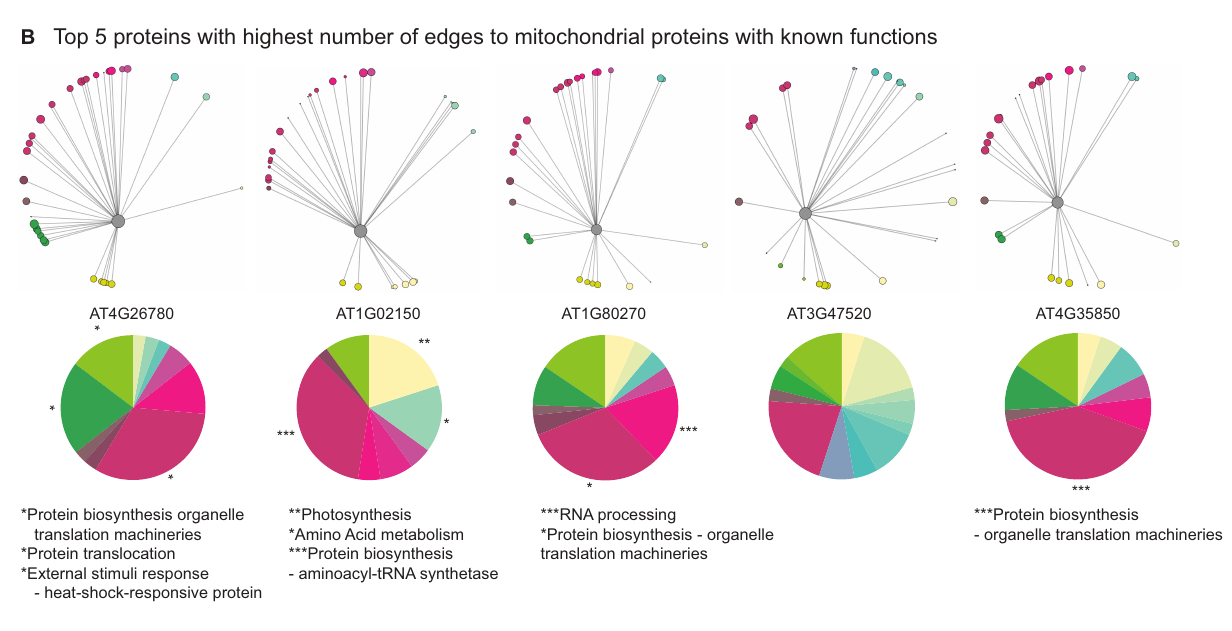
FIGURE 5 | Identification of candidate functions for mitochondrial proteins with unknown functions. Pearson correlation was carried out on CSE pre-processed data spanning the mitochondrial set, over 370 unique conditions comprising the AtGenExpress Expression Atlas. Out of this list, a sub-population of genes was established which had unknown functional annotations. This sub-population was then analyzed to identify significant interactions with mitochondrial proteins with known functions, resulting in a suite of 109 mitochondrial proteins with unknown functions. By annotating the functional categories of the known mitochondrial genes, putative functional relationships can be assigned to these as yet uncharacterized proteins. (A) Network representation of the interactions between 109 mitochondrial proteins with no annotated functions and 248 mitochondrial proteins with known functions. (B) The five proteins with no annotated functions displaying the highest number of edges to the mitochondrial set are shown, with a functional breakdown of the distribution of edges. Significant over-representation of a given functional category was assessed using a z -score approach and the results have been marked with the following: * p < 0.05; ** p < 0.01; *** p < 0.001.